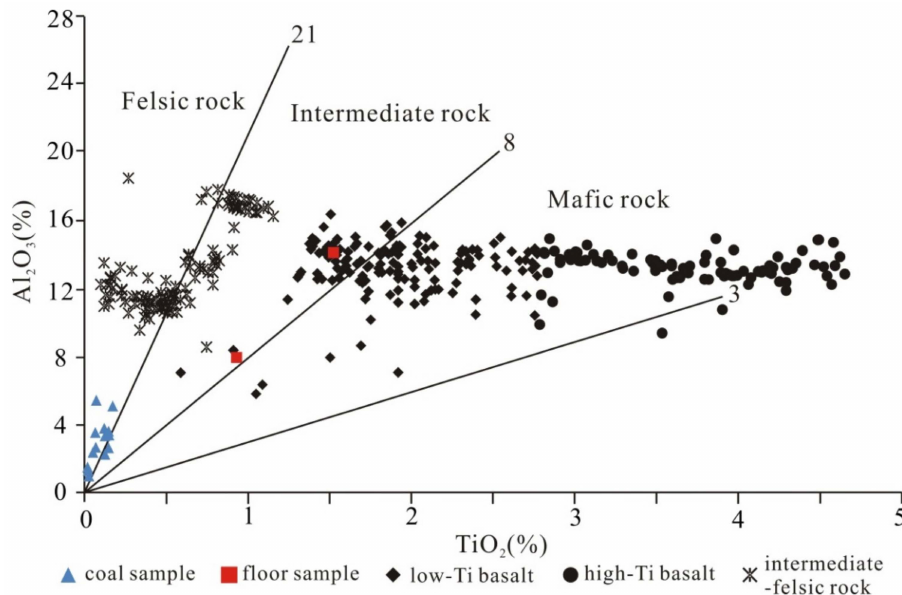
Figure 14. Plot of TiO 2 versus Al 2 O 3 contents for coal and floor samples, in comparison to the low Ti basalt and high-Ti basalt [8,9,34–36] as well as intermediate-felsic rock